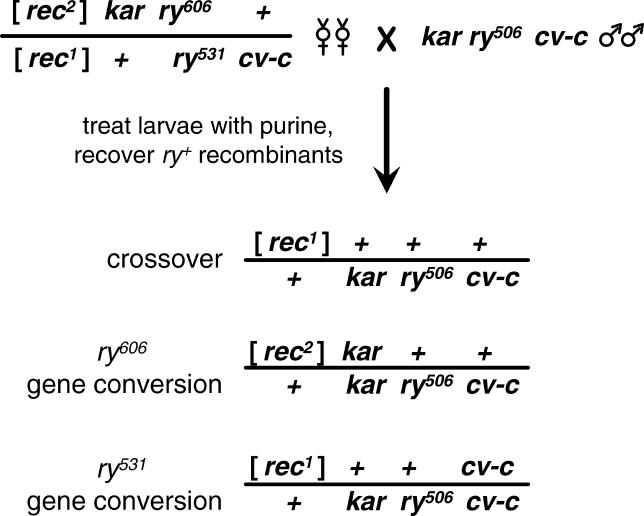
Intragenic Recombination at rosy
Cross scheme used to recover recombination events within the ry gene. Brackets indicate that females were either trans-heterozygous for different rec alleles or were completely wild-type at rec. The three types of ry+ progeny recovered after purine selection are indicated.